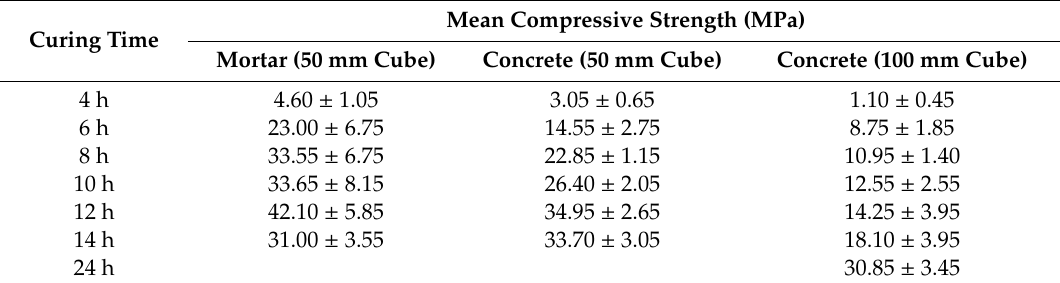
Table 4. The e ff ect of curing time on 7-day compressive